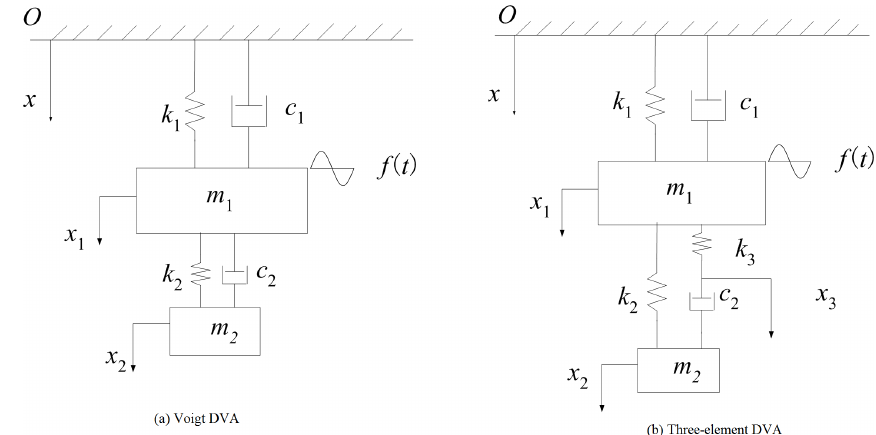
Figure 1. Schematic diagram of